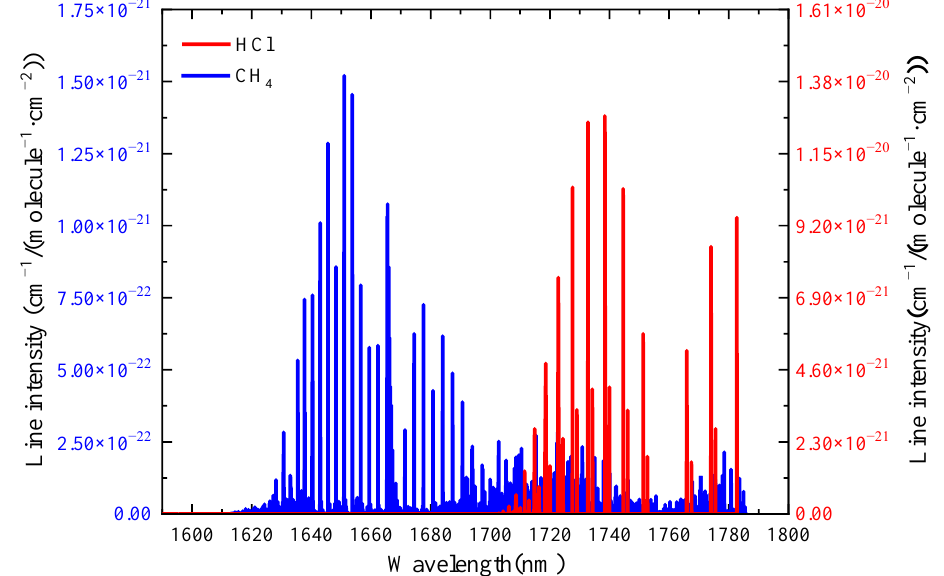
Figure 1. Absorption spectrum of HCl and CH 4 in the near infrared region retrieved from the HITRAN database.